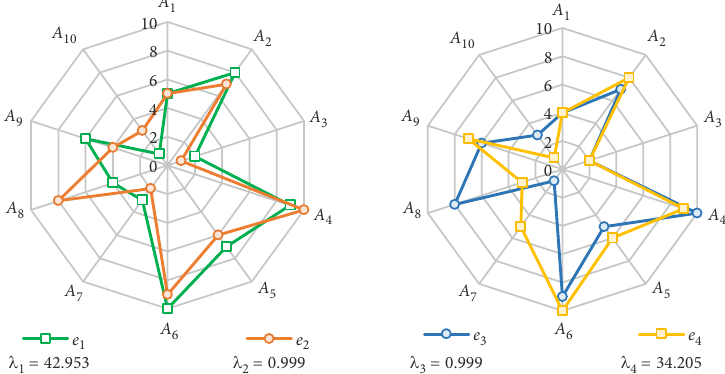
Figure 3. Rankings of projects under different experts’